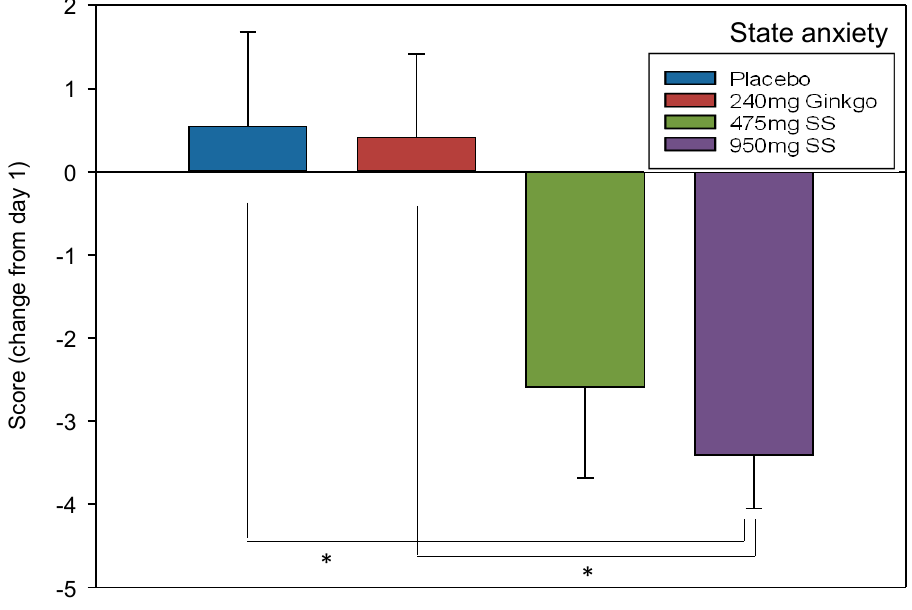
Figure 7. State anxiety change. Mean ( ± SEM) subjective state anxiety ratings (changed from Day 1 rating) of participants following 28 days of supplementation with 475 mg Sideritis scardica (SS), 950 mg SS, active control (240 mg Ginkgo biloba ) or placebo control. * p < 0.05, ** p < 0.01. t , trend.